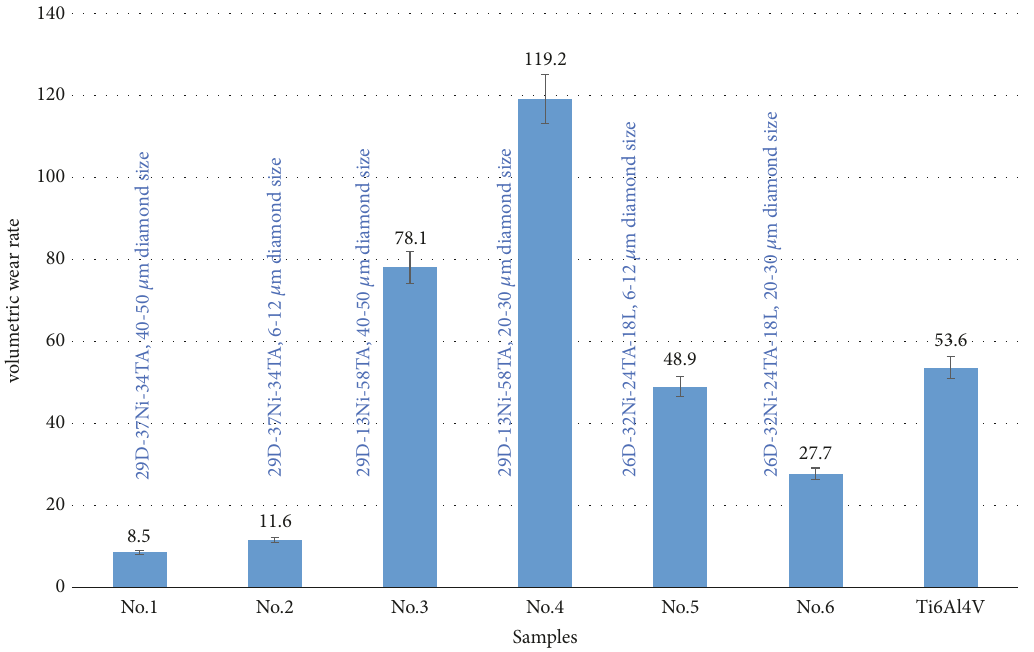
Figure 9: Volumetric wear rate (missing volume) of samples during impact-abrasive test measured by 3D OSP, × 10 3 𝜇 m 3